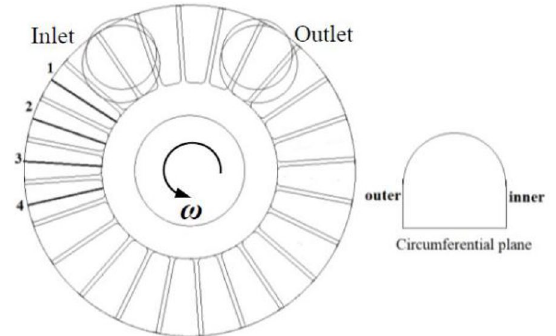
Figure 10 Positions of different circumferential planesCavitation number